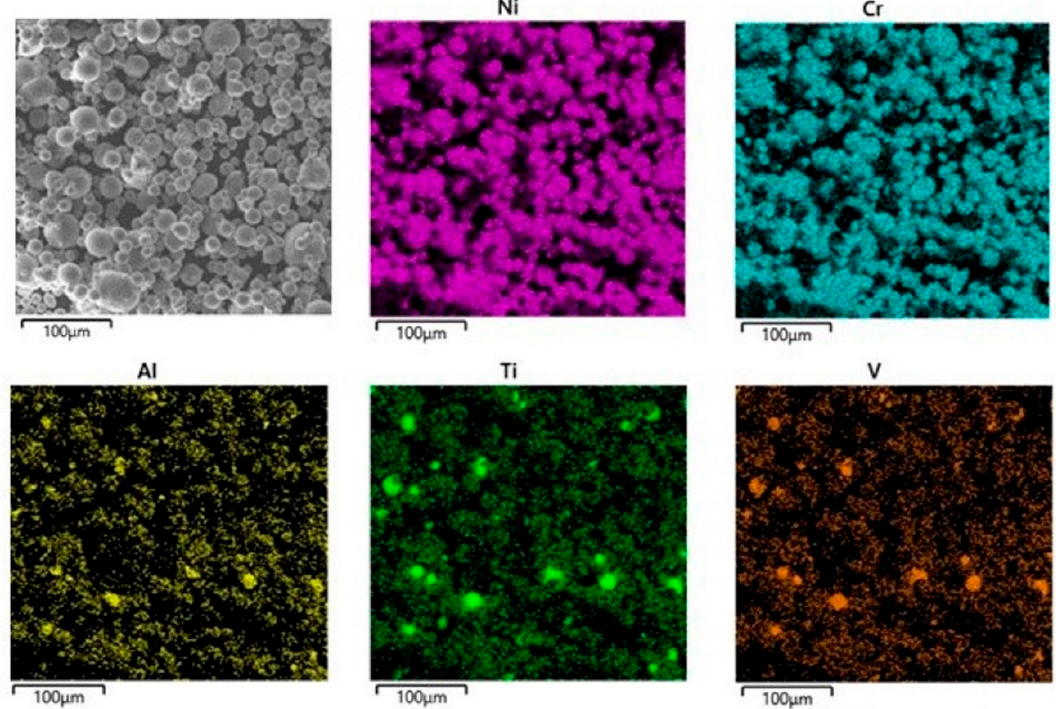
Figure 1. SEM image and EDS maps of the mixed powder composed of 99 wt.% IN625 and 1 wt.% Ti6Al4V.